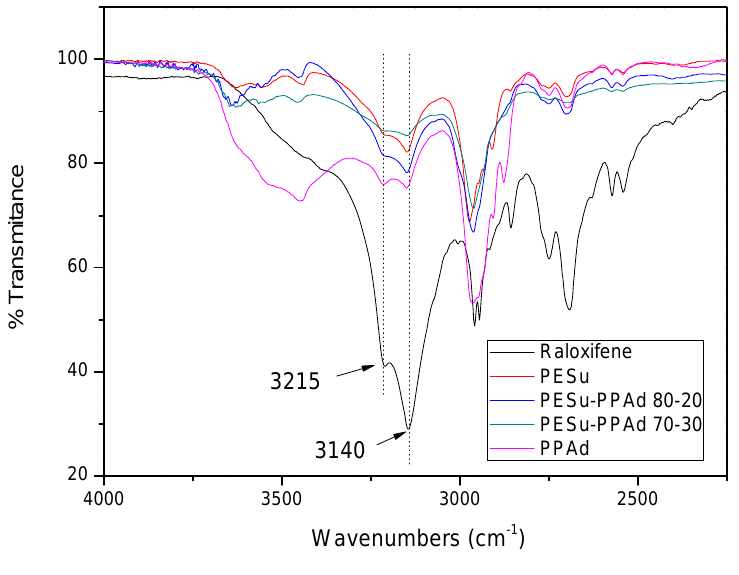
Figure 10. Comparative FTIR spectra of Raloxifene HCl and the drug loaded